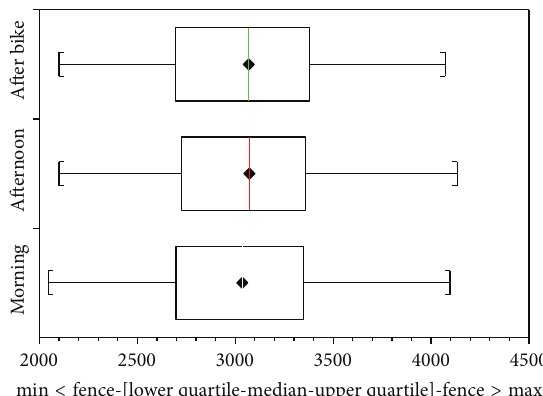
Figure 1: Interquartile variations in volume in the morning, the afternoon without using elastic stockings during the day, and after the treadmill session using stockings (Assessment 1).